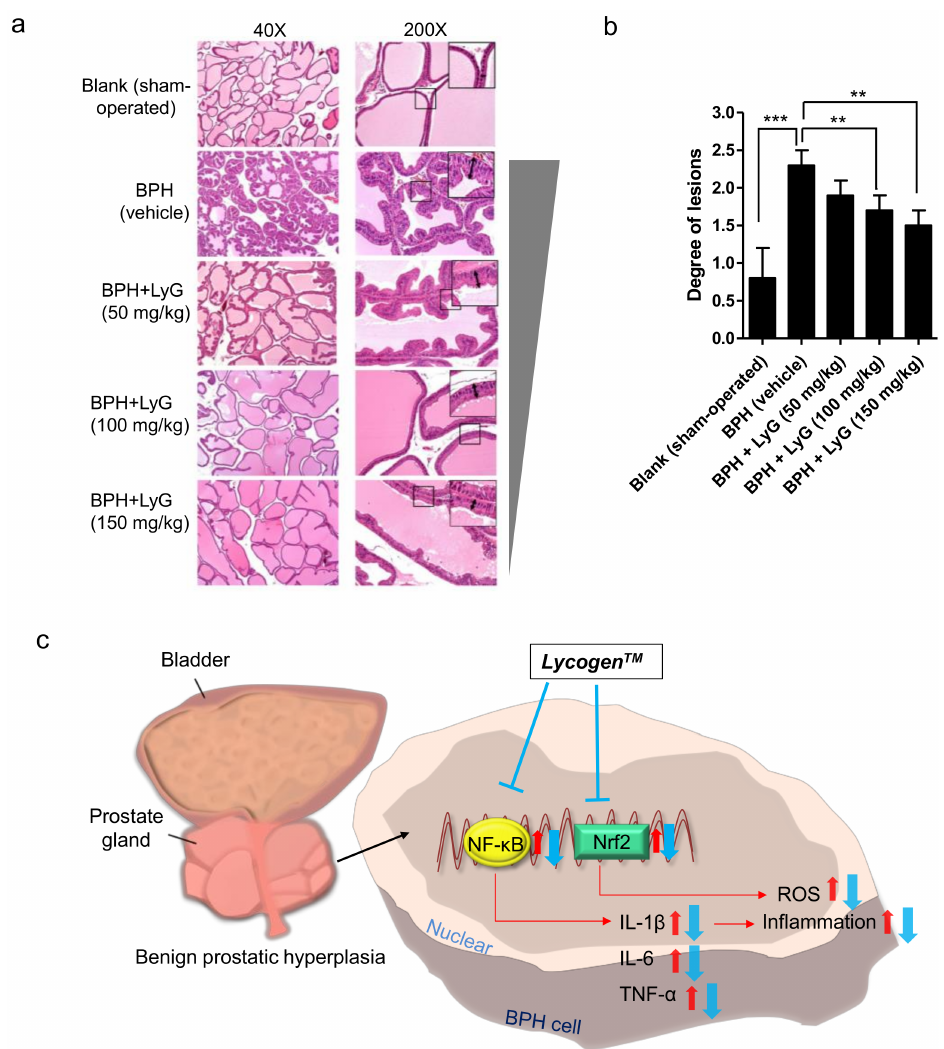
Figure 4. The histopathology of the prostate in the BPH-induced rats after being treated with Lycogen™. ( a ) A comparison of different doses of Lycogen on prostate hyperplasia according to H&E staining of the prostate sections. The H&E staining sections were photographed by microscope at 40- and 200-fold magnifications. The thickness of the epithelial was marked with double-headed arrows. The enlarged images represented the area indicated using a black square. The grey triangle represented a dose-dependent manner of the inhibition effect of Lycogen™ in BPH tissues. ( b ) The quantification of H&E staining sections was done according to a five grade score, included score 1: reflects minimal hyperplasia (<1%); score 2: reflects slight hyperplasia (1–25%); score 3: reflects moderate hyperplasia (26–50%); score 4: reflects moderately severe/high hyperplasia (51–75%); score 5: reflects severe/high hyperplasia (76–100%). The data were presented as a mean ± SEM. Blank: sham-operated; BPH: BPH-induced rats; BPH + LyG: BPH-induced rats combined with a Lycogen treatment (50, 100 and 150 mg/kg). Error bars represent ± SEM. ** p <0.01 and *** p <0.001, Student’s t -test. ( c ) Postulated mechanisms of how Lycogen may reduce BPH. References utilized in this composite figure include [1,2,6,7,30–32]. Red arrow represented up-regulation of gene/protein level; blue arrow represented down-regulation of gene/protein level. Blue T bar represented the inhibition effect of